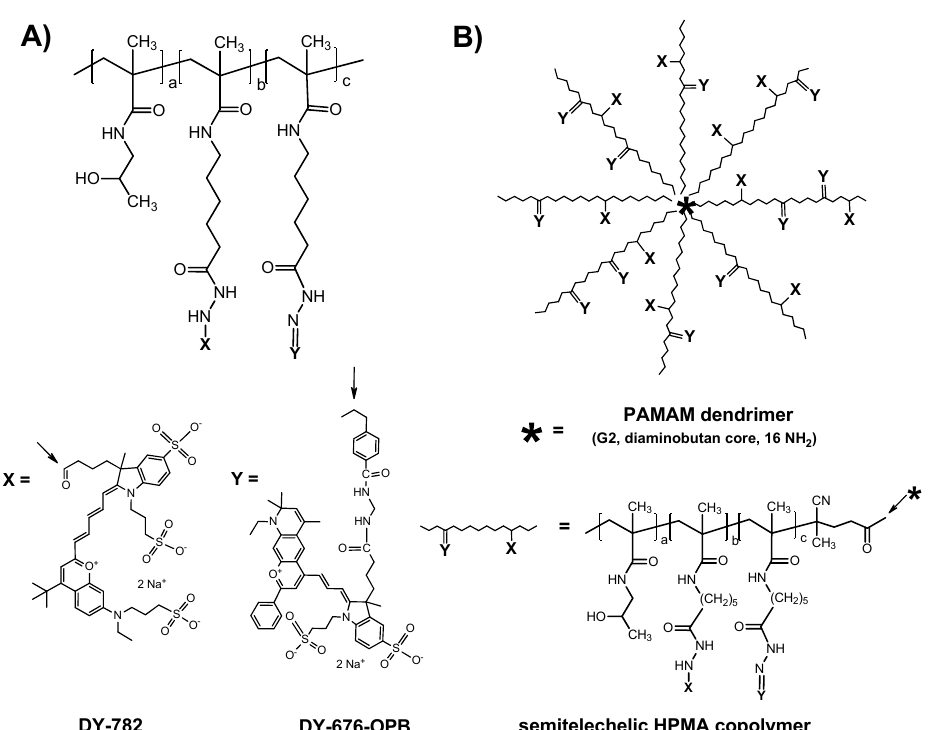
Figure 1. Schematic structure of dual-labeled polymer carriers with Dyomics-782 bound via a non-degradable hydrazide bond and Dyomics-676 bound via a pH-sensitive hydrazone bond—( A ) linear N -(2-hydroxypropyl)methacrylamide (HPMA)-based polymer and ( B ) star HPMA-based polymer. Reprinted with permission from [31], Copyright [2012], American Chemical Society.